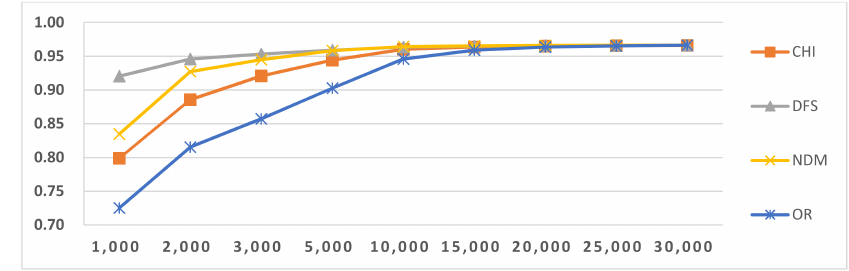
Figure 9. Results of LI in Latin script languages when selecting SVM and mix-gram (2–3).